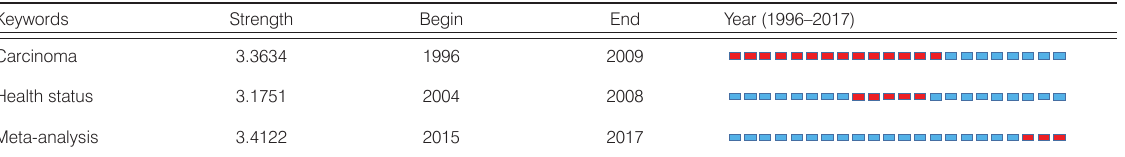
Table 2. The top 20 keywords in research on self-management by patients with breast cancer.